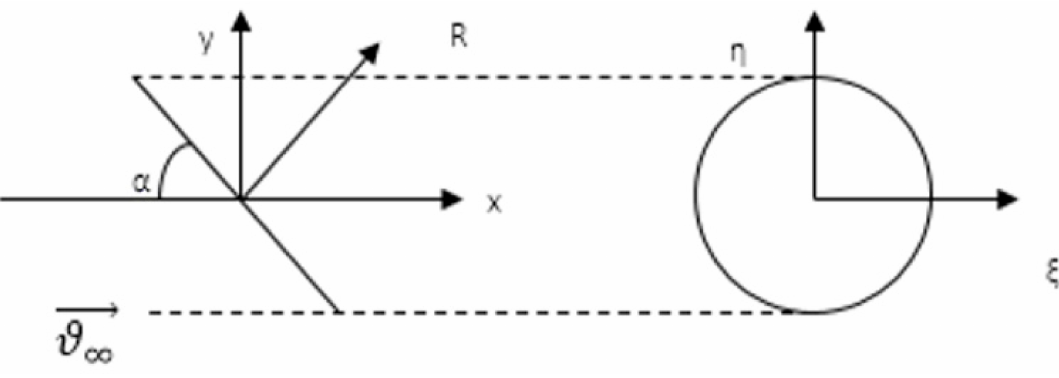
Figure 5. Plate mapping on a